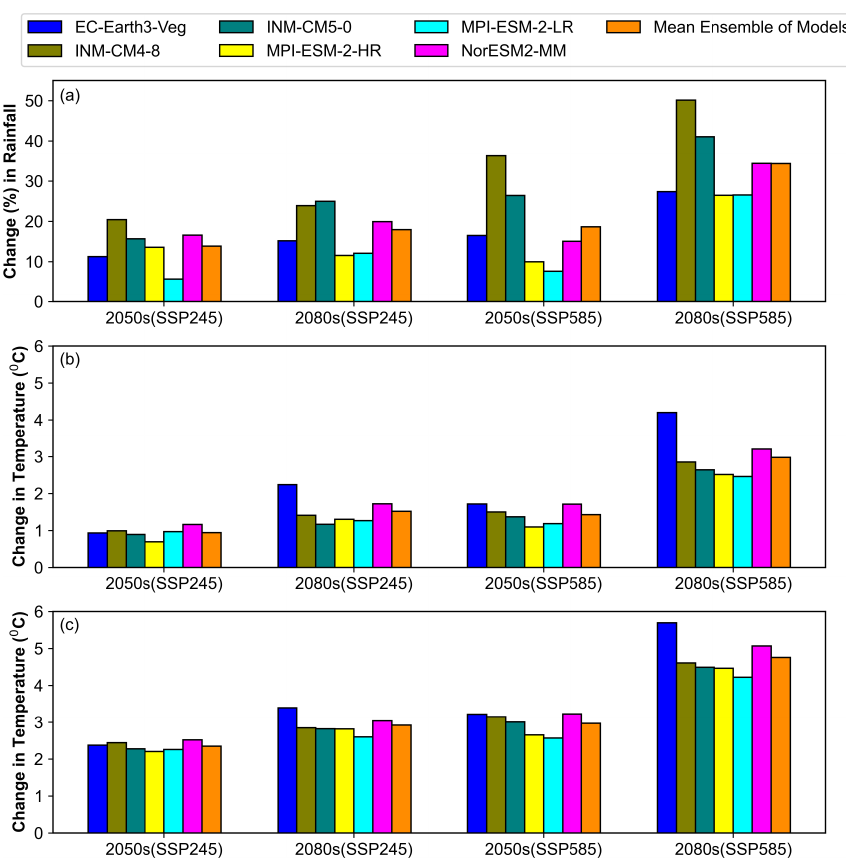
Figure 13. Projected changes in the (a) mean annual rainfall, (b) T max , and (c) T min in the sub-basin using different CMIP6 GCMs under the SSP245 and SSP585 scenarios in the 2050s and